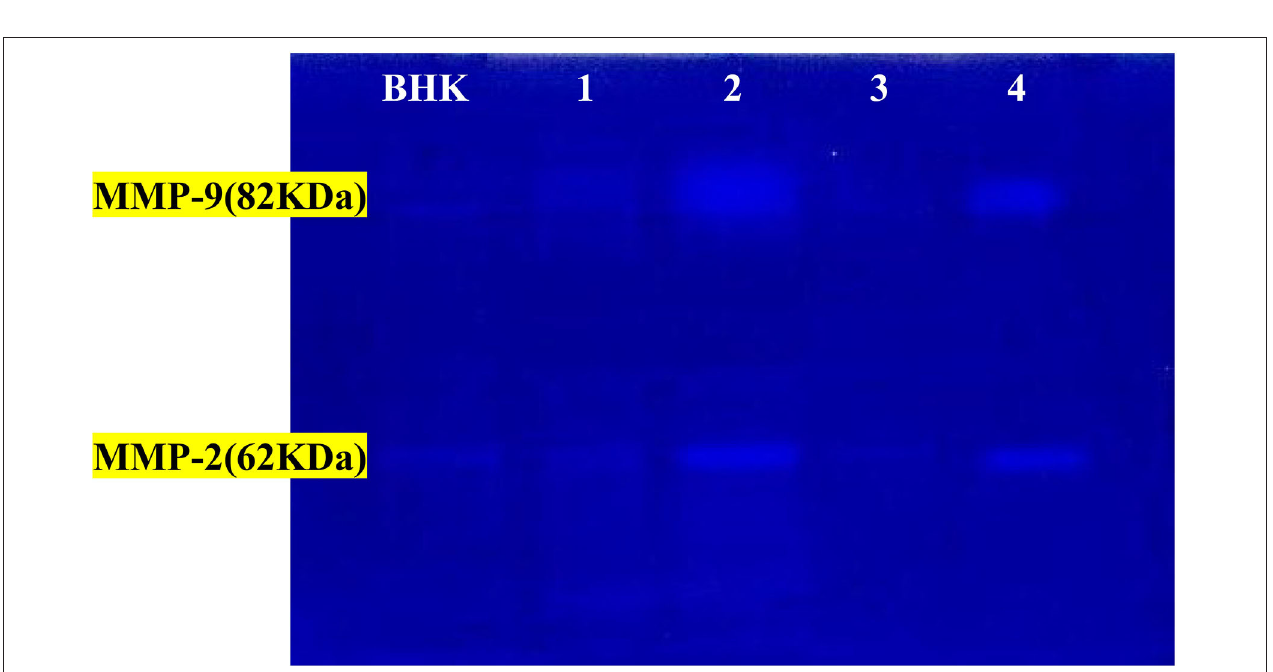
FIGURE 10 | The activity of MMP-2 and MMP-9 by gelatin zymography. Lanes 1 = PRP-group; lanes 2 = control + ve in cat; lanes 3 = PRP groups; lanes 4 = control + ve group in dog. BHK lane is a control marker from baby hamster kidney cells transfected with active MMP-9 (82 kDa) that are indicated by arrows and MMP-2 (62